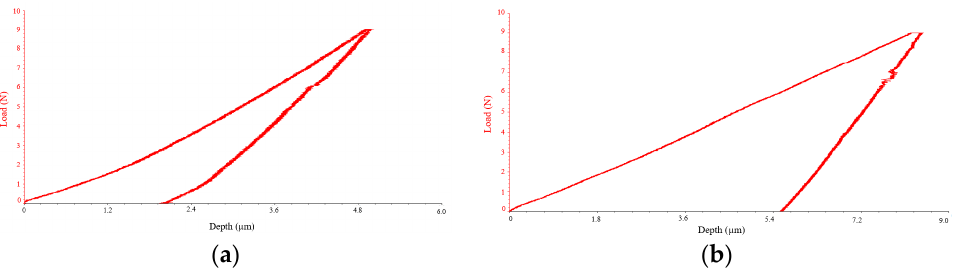
Figure 14. Indentation curves for samples nitride without ( a ) and with the grid in ( b